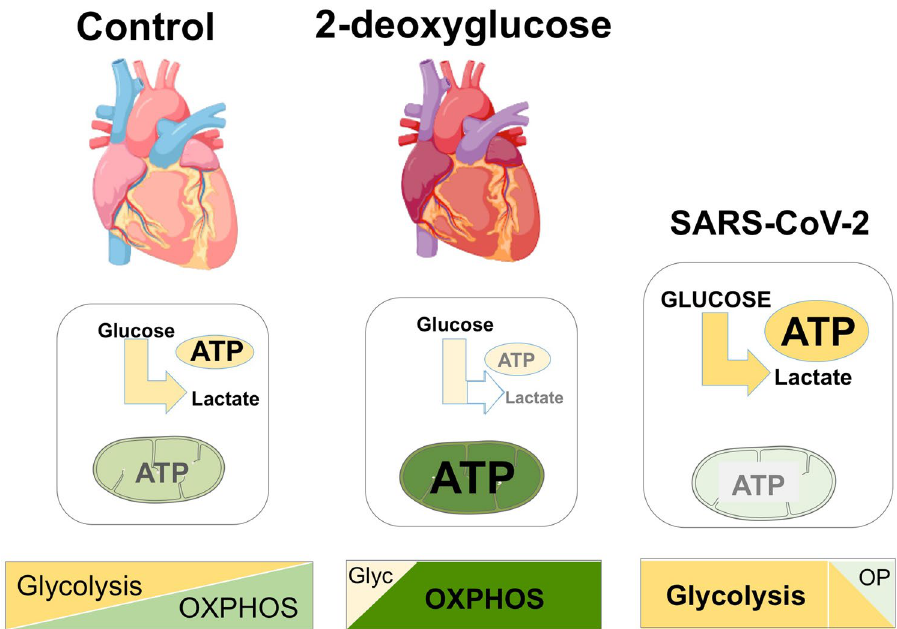
Figure 4. The effect of 2DG on the balance between glycolytic and mitochondrial energy production contrasts with that of SARS-CoV2. The proteomic signature found in this study suggests that the principle effect of 2-deoxyglucose (2DG) in the heart is to shift the equilibrium from glycolytic to mitochondrial (OXPHOS/OP) ATP production, as occurs in cultured cells. These effects are opposite to those of SARS-CoV2 infection in cells (illustrated to the right), and so support the idea that 2-deoxyglucose could have anti-viral properties in vivo as well as in cultured cells 3